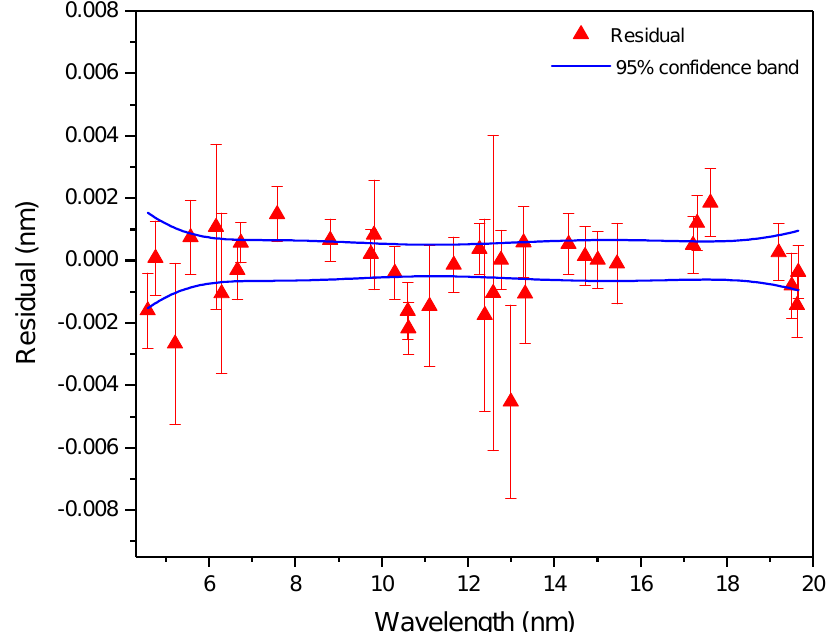
Figure 1. Residual of the adopted wavelength of the calibration lines with respect to their calibrated wavelength. The individual uncertainties of the data points are as described in the text. The solid (blue) line corresponds to the 95% confidence band of the calibration